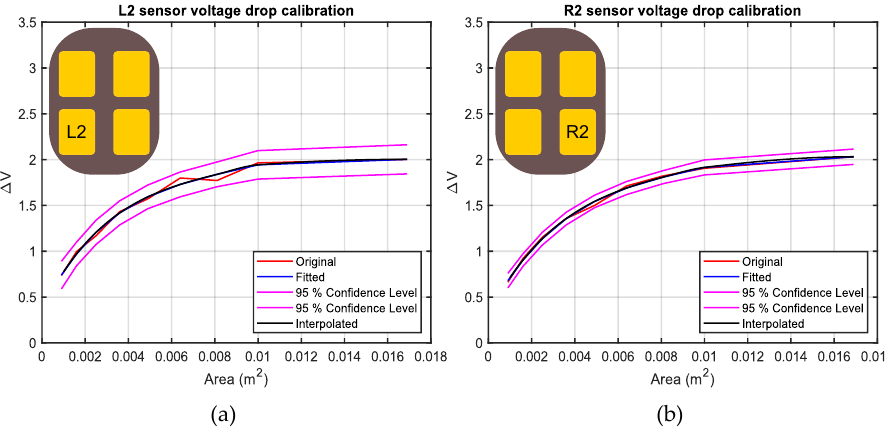
Figure 12. Calibrated voltage drop curve for L2 and R2: ( a ) L2 sensor; ( b ) R2